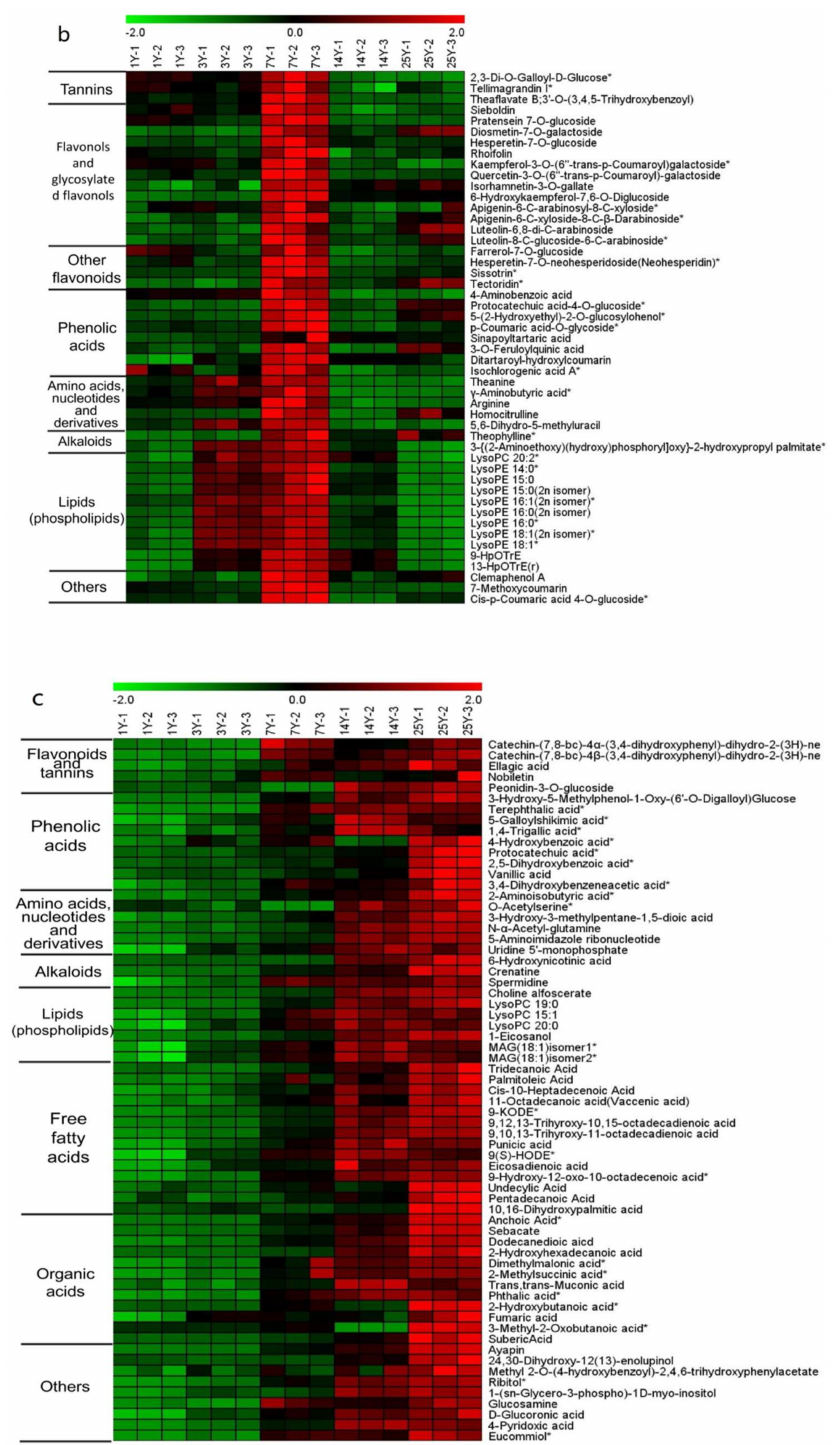
Figure 5. The heat map of differential metabolites which had a similar change tendency by K-means analysis. Red represents high contents, while green represents low contents (ranges from − 3.0 to 3.0). “*” means there are isomers existing probably. ( a ): Metabolites in decreasing tendency with storage time extended; ( b ): metabolites which were detected at their highest levels in 7 y samples; ( c ): metabolites in increasing tendency with storage time